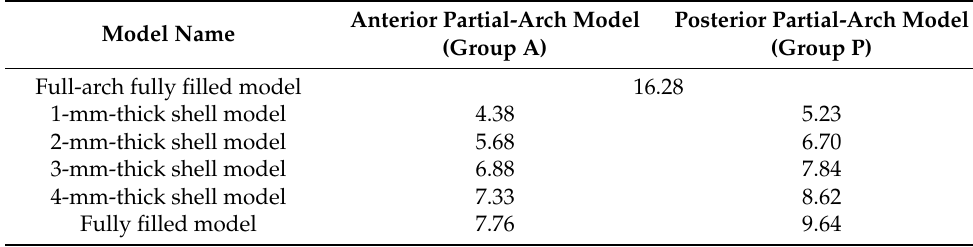
Table 1 lists the resin consumption according to the type of printed tooth model. Table 1. Resin consumption according to model design (unit: mL).